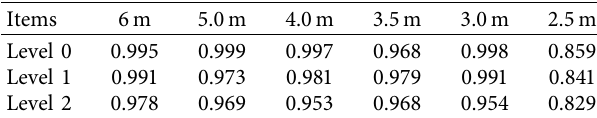
Table 4: Test results of beam bridge (tailwind, side).